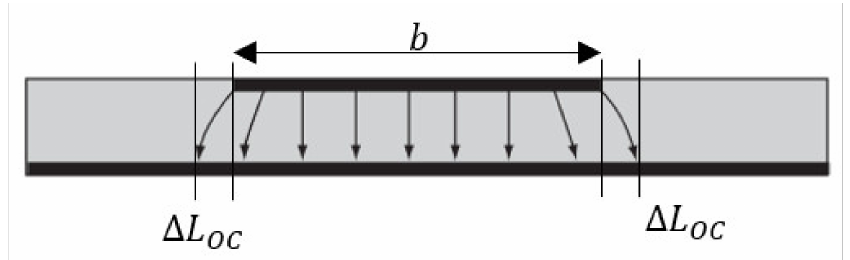
Figure 4. Cross-section of the patch